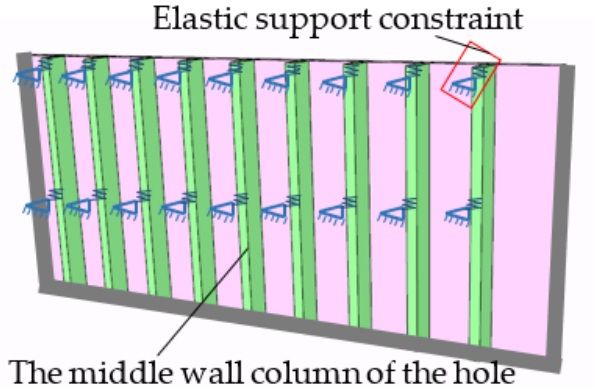
Figure 4. The simplified system composed of wall columns and walls.